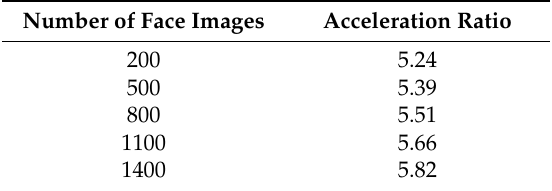
Figure 18. Comparison of CPU and GPU operation time (using self-collection database). Table 5. Acceleration ratios of CPU and GPU using the self-collection face database.